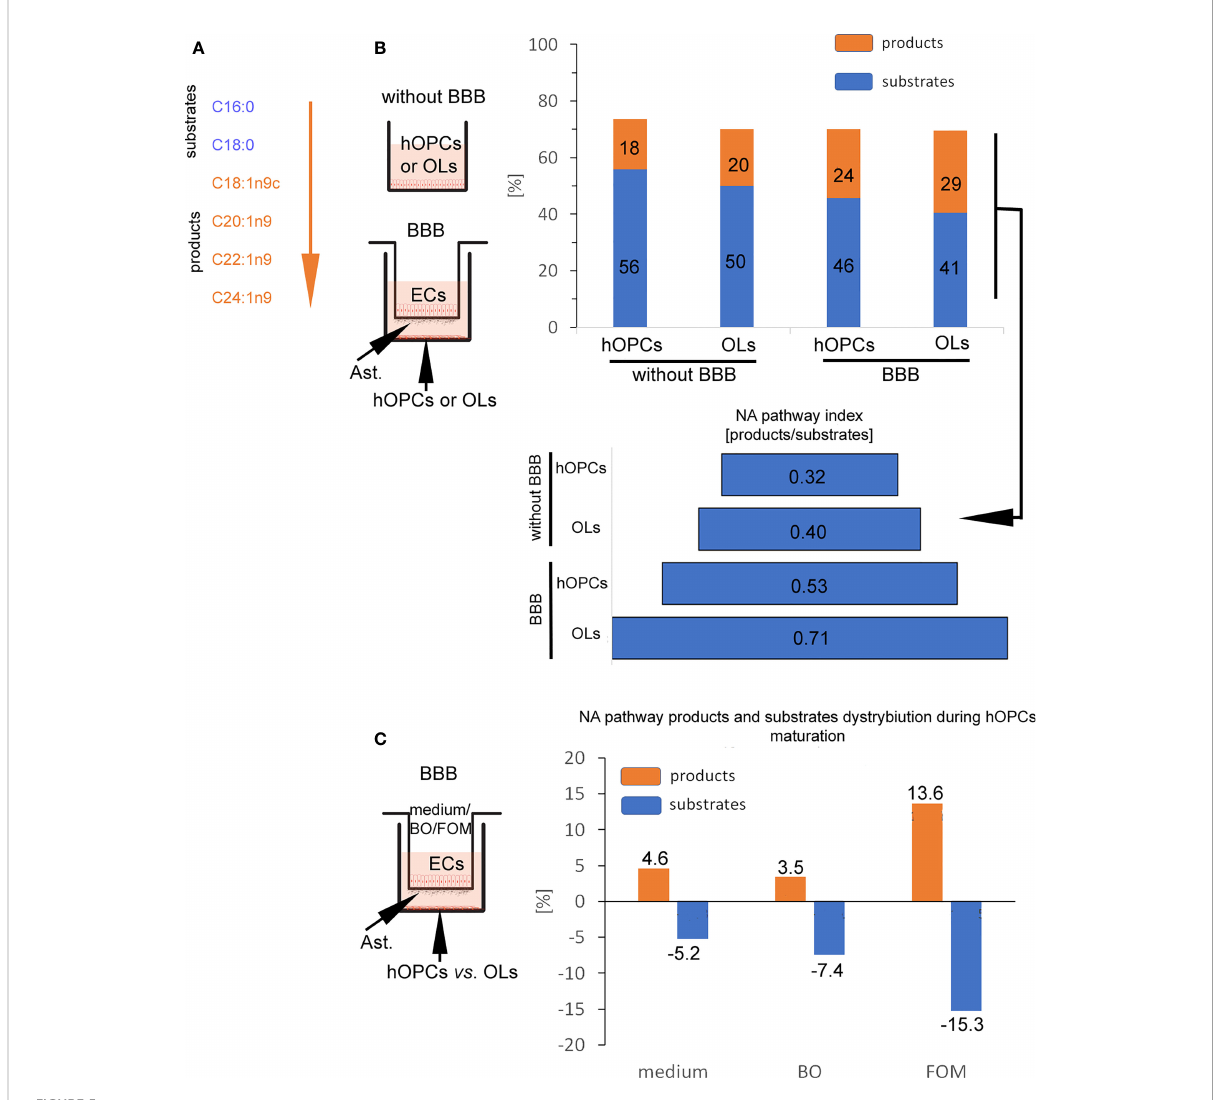
FIGURE 5 BBB cells supplemented with FOM enhanced NA synthesis by mature OLs. (A) The division into substrates: C16:0, C18:0 vs . products: C18:1n9c, C20:1n9; C22:1n9, C24:1n9 was set arbitrary based on the starting enzyme D 9 desaturase, creating a carbon(C9)/carbon(C10) double bond. (B) BBB cells initiate lipid metabolism to NA synthesis. The distribution of substrates and products involved in NA synthesis by OPCs and OLs is presented as the percentage of all lipids and as NA pathway index. Data are presented as the mean calculated from three independent experiments. (C) The effect of BBB supplementation with FOM and BO on the NA pathway is presented as the percentage of decreasing substrates vs . product increment. Data are presented as the mean calculated from three independent